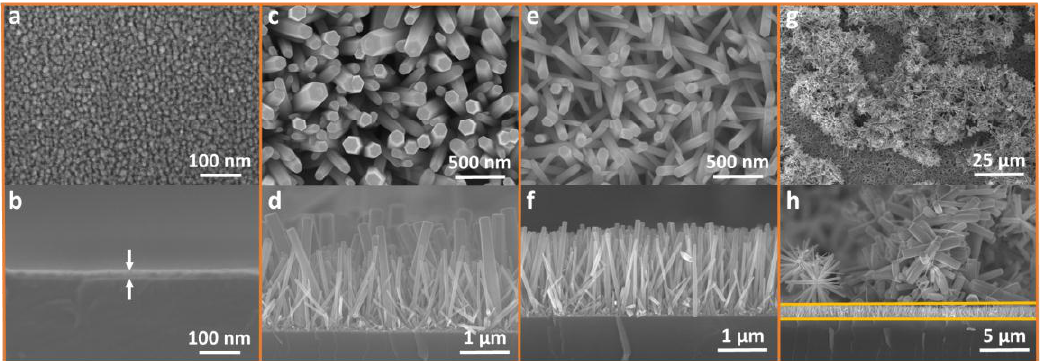
Figure 2. Scanning electron microscope (SEM) (top and side views, respectively): ( a , b ) Seed; ( c , d ) ZnO nanorods (ZNRs) fabricated using the ACG method; ( e , f ) ZNRs fabricated using the MAG method; ( g , h ) ZnO debris on the surface of vertical ZNRs.